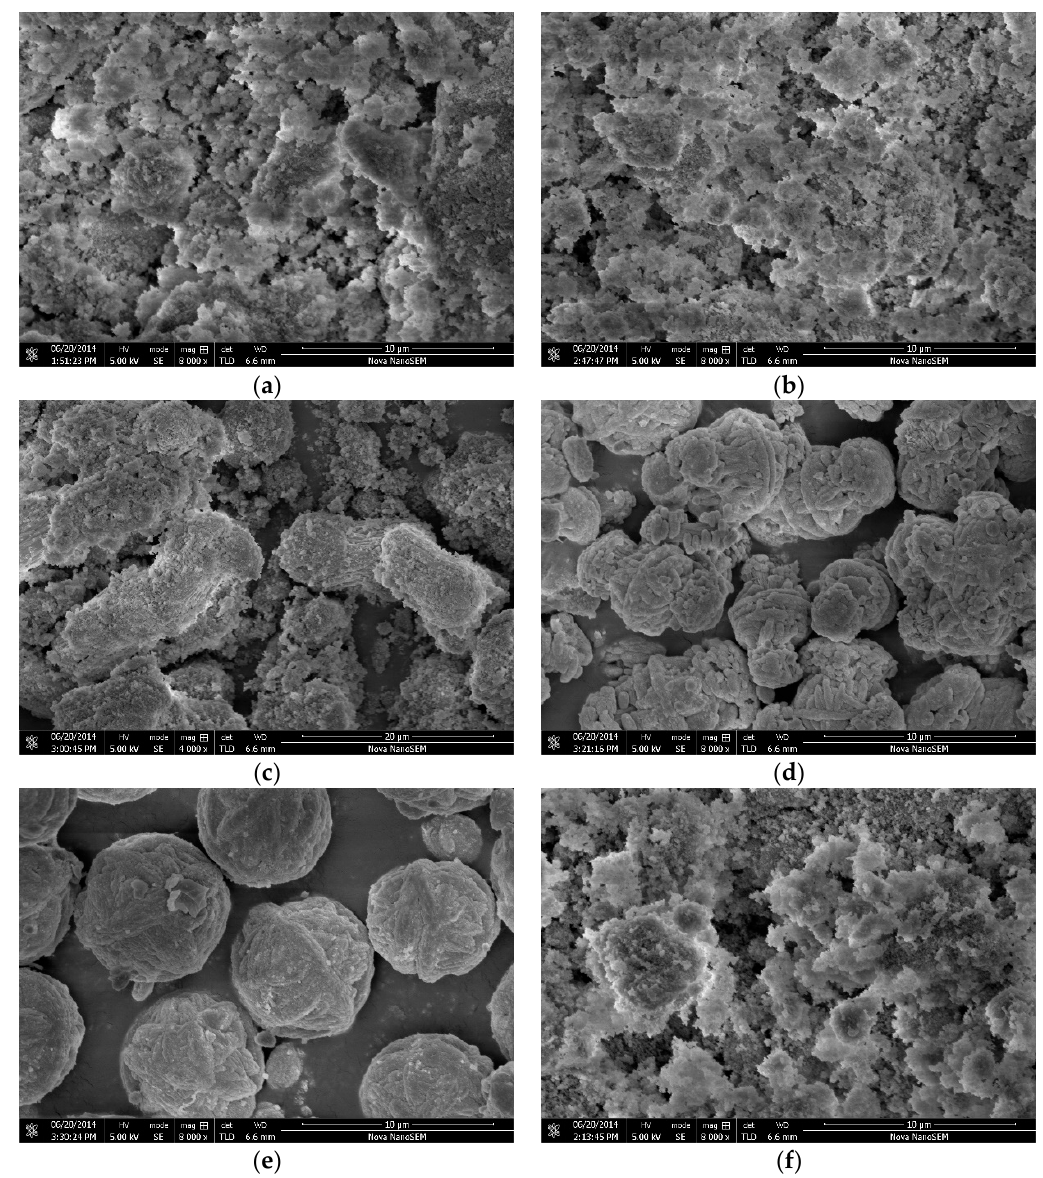
Figure 6. SEM images of K-A-S-H samples ( a ) K-A-S-H2.0 2 -3d-60, ( b ) K-A-S-H2.0 2 -3d-95, ( c ) K-A-S-H0.5 2 -7d-95, ( d ) K-A-S-H1.0 2 -7d-95, ( e ) K-A-S-H2.0 2 -7d-95, and ( f ) K-A-S-H2.0 1 -3d-95.